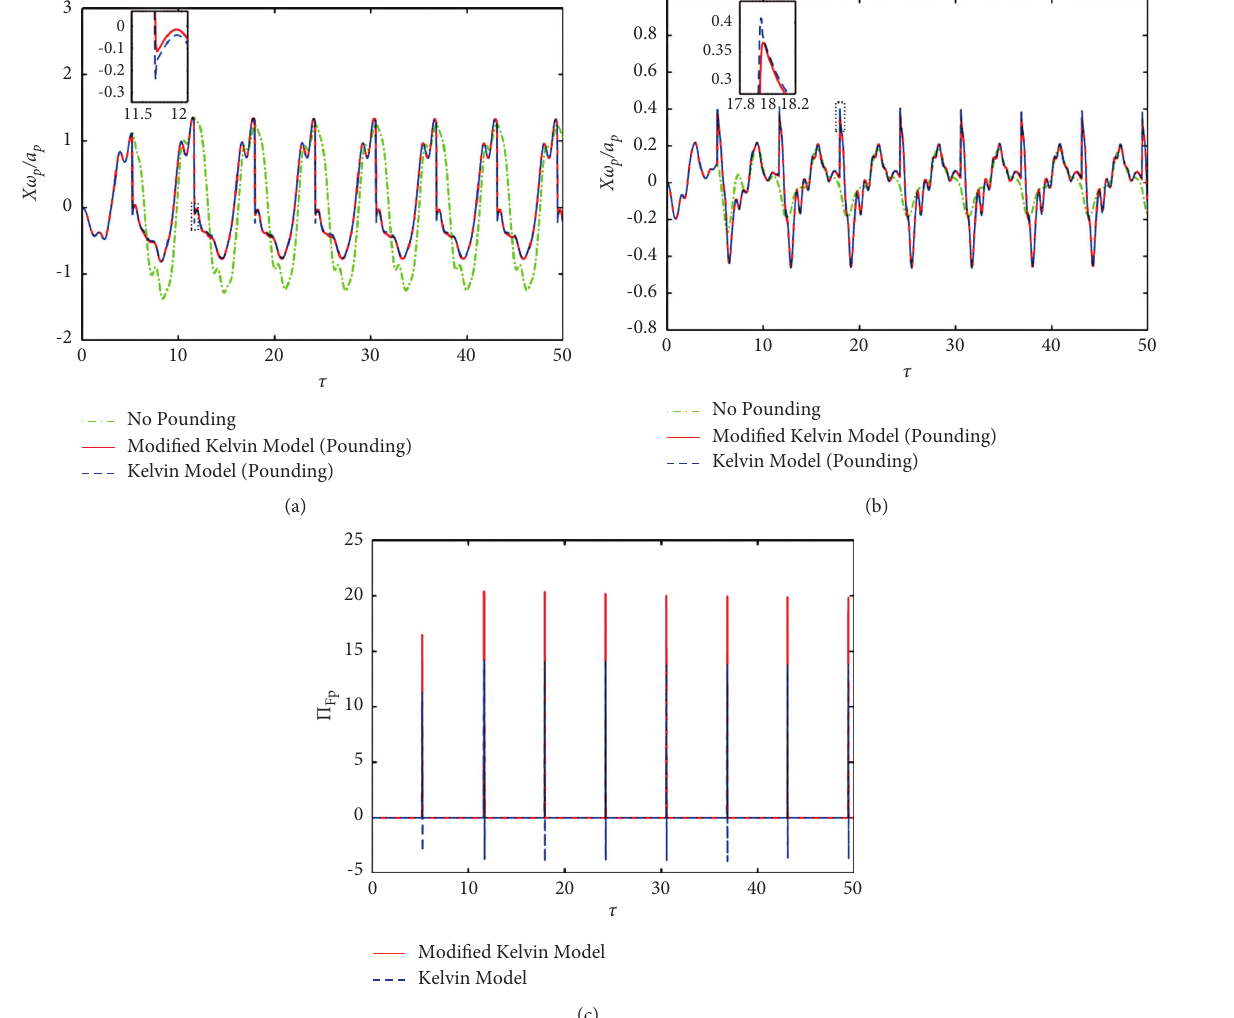
Figure 6: Two structures using the modified Kelvin model and the Kelvin model to consider the pounding of the third story. (a) Velocity histories of the left structure. (b) Velocity histories of the right structure. (c) Pounding force comparison